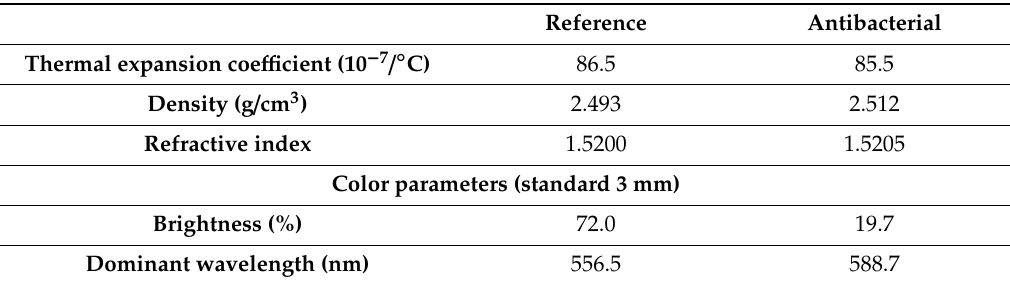
Table 4. Physical and optical test results.